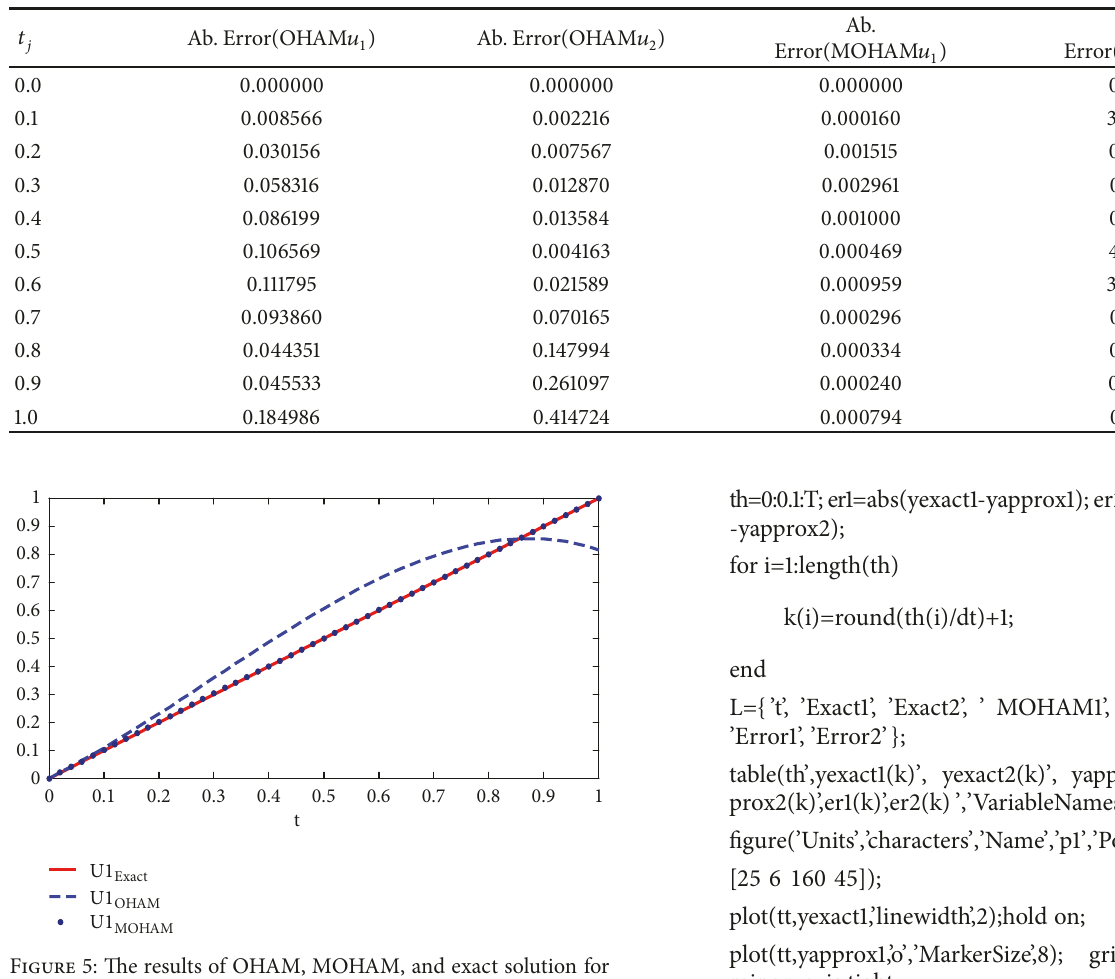
Table 6: Absolute errors of applying OHAM and MOHAM for Example 2.